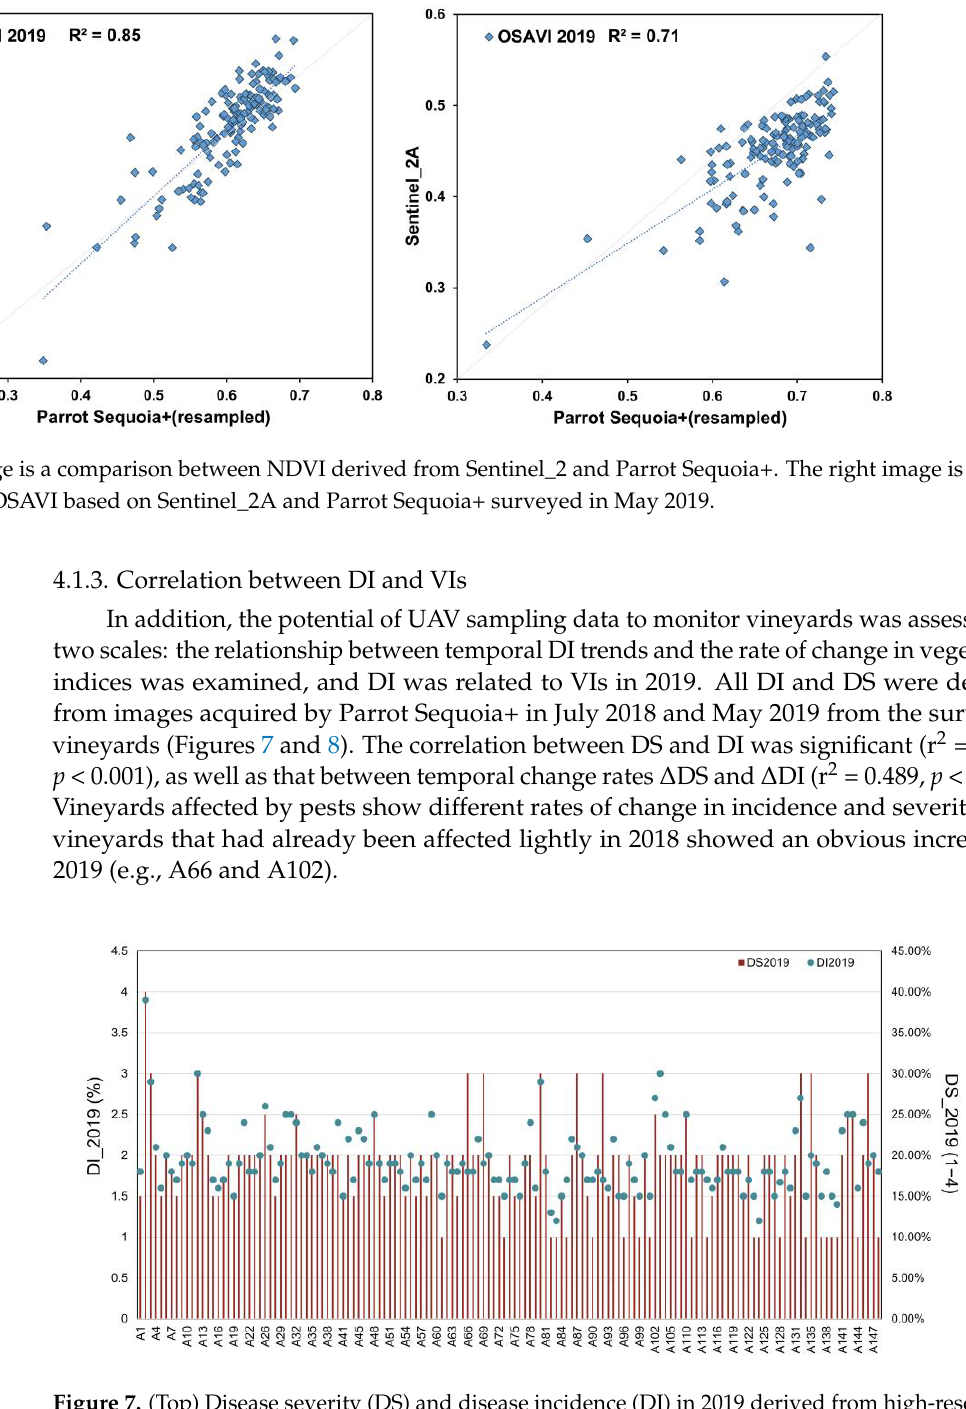
Figure 7. (Top) Disease severity (DS) and disease incidence (DI) in 2019 derived from high-resolution RGB images. The X-axis indicates the vineyards sampled, which were labeled from A1 to A148. Due to lack of space, not all labels are shown.